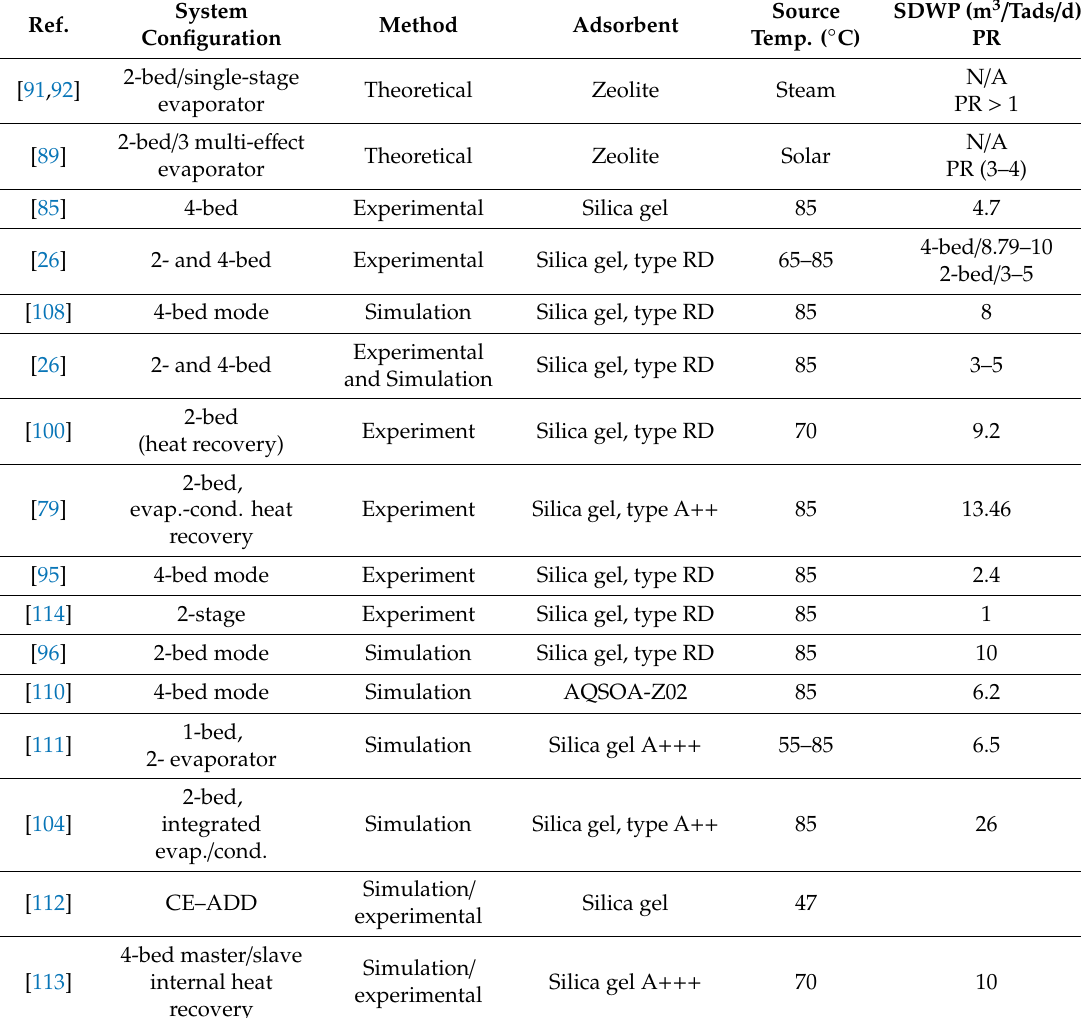
Table 6. Summary of reviewed design and performance parameters of ADD configurations.